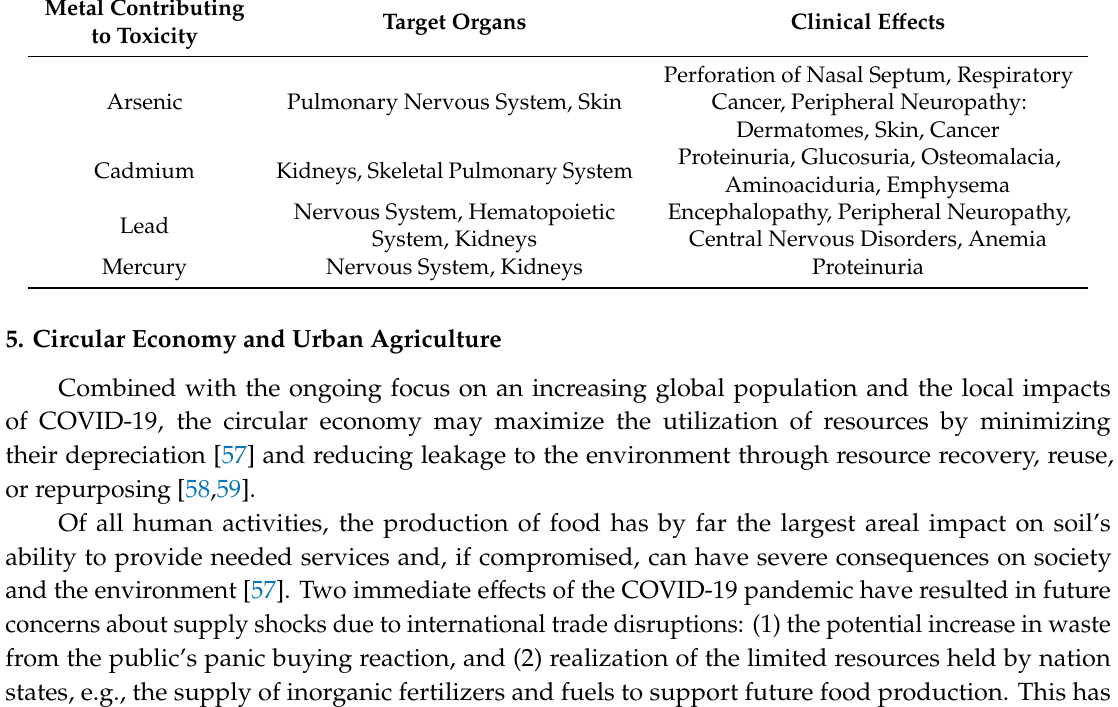
Table 1. Clinical aspects of chronic toxicities (modified and adopted from Mahurpawar [56]). Metal